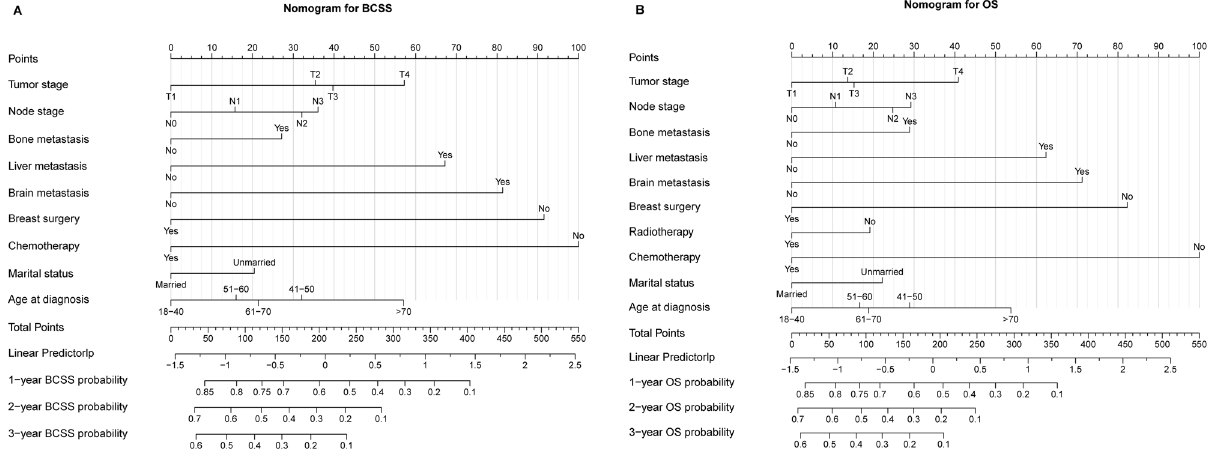
Figure 3. Nomograms for BCSS ( A ) and OS ( B ) in training cohort.